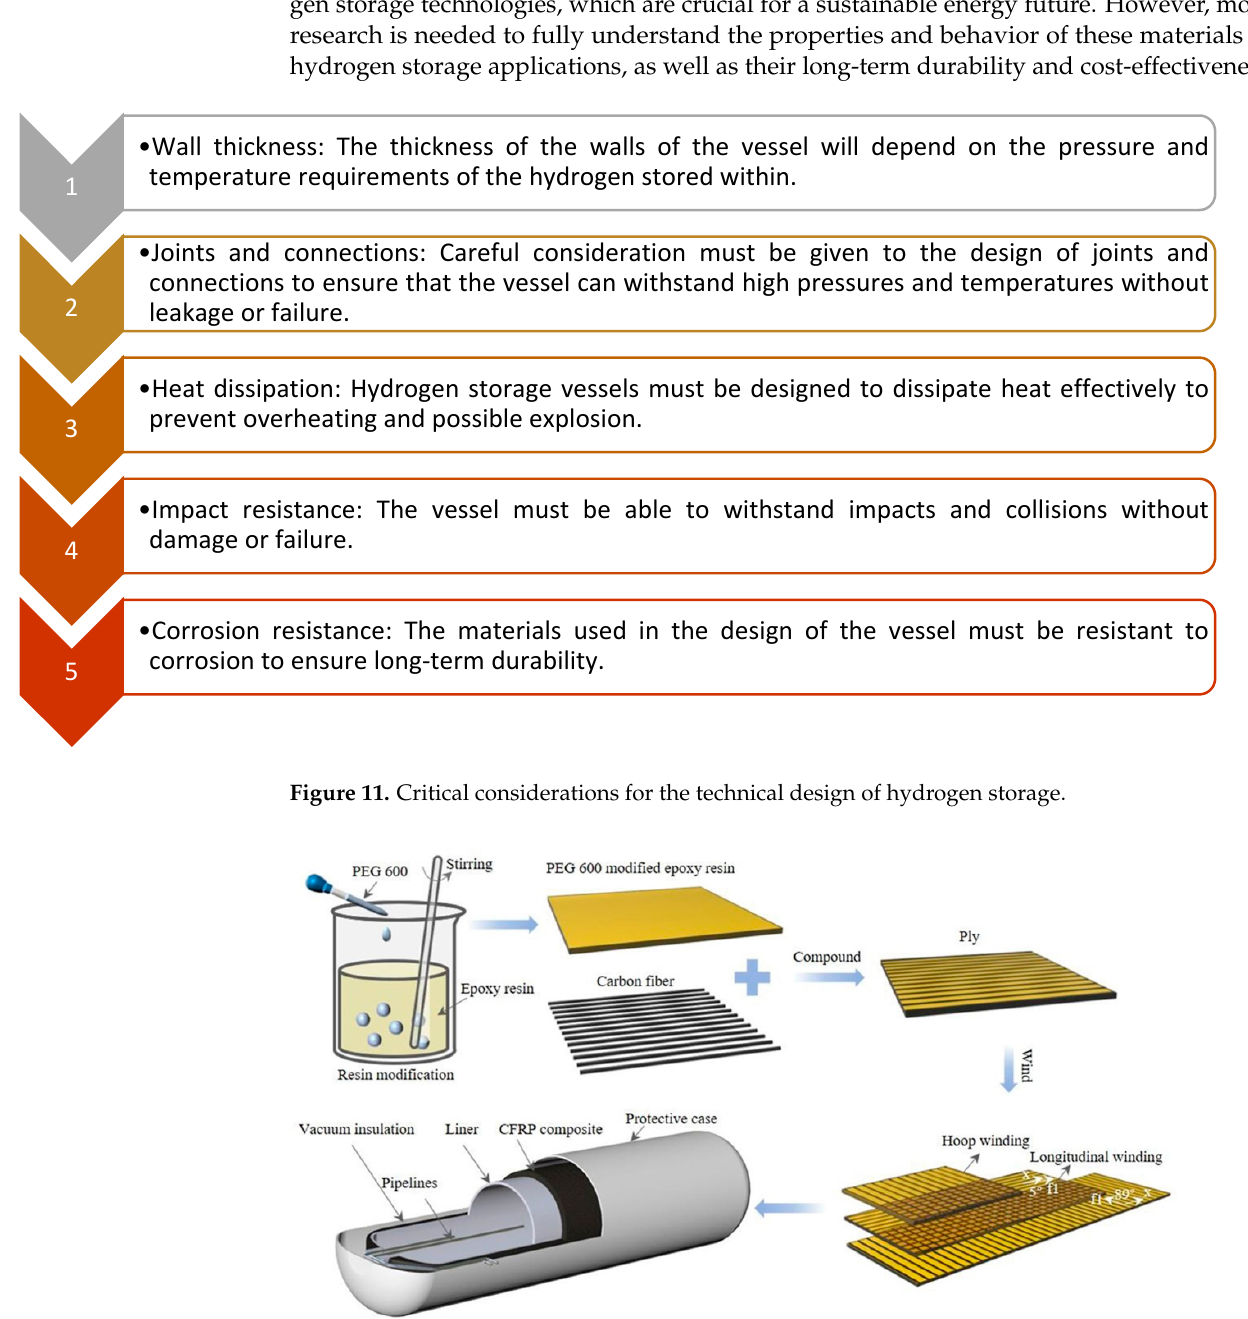
Figure 12. Properties improvement of a composite layer of a cryo-compressed hydrogen storage vessel [72].